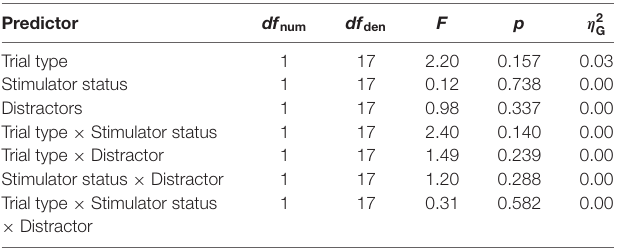
TABLE 6 | ANOVA table of the centro-parietal P3 peak amplitudes. Predictor df